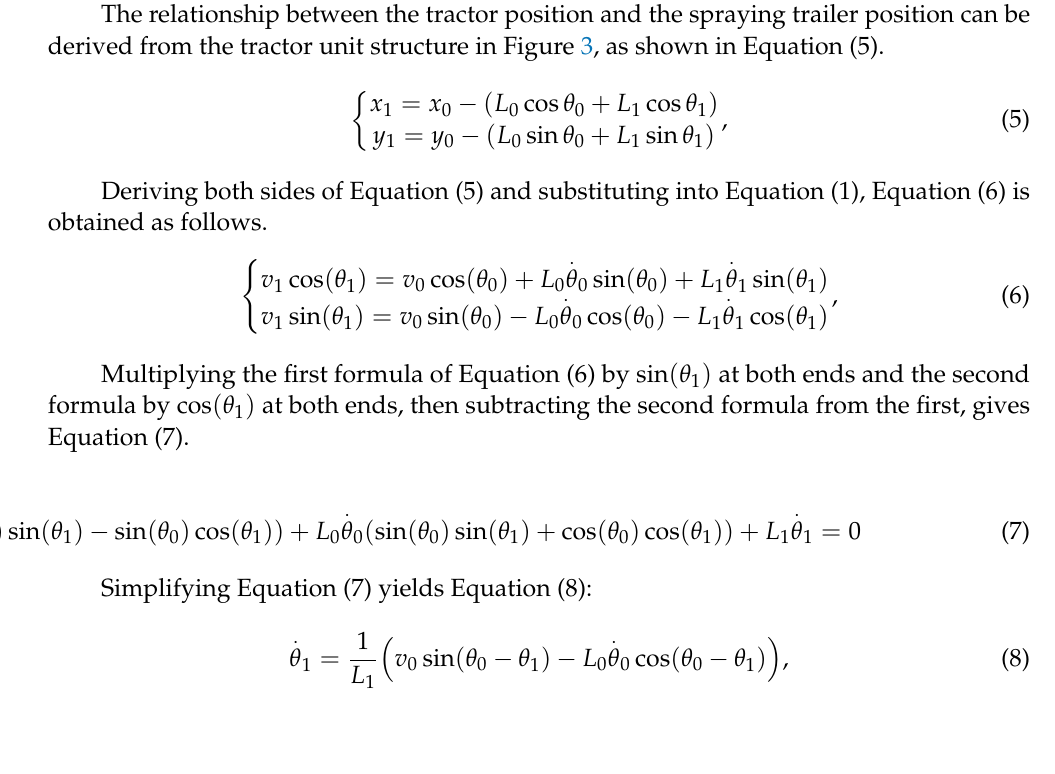
The relationship between the tractor position and the spraying trailer position can be derived from the tractor unit structure in Figure 3, as shown in Equation (5).